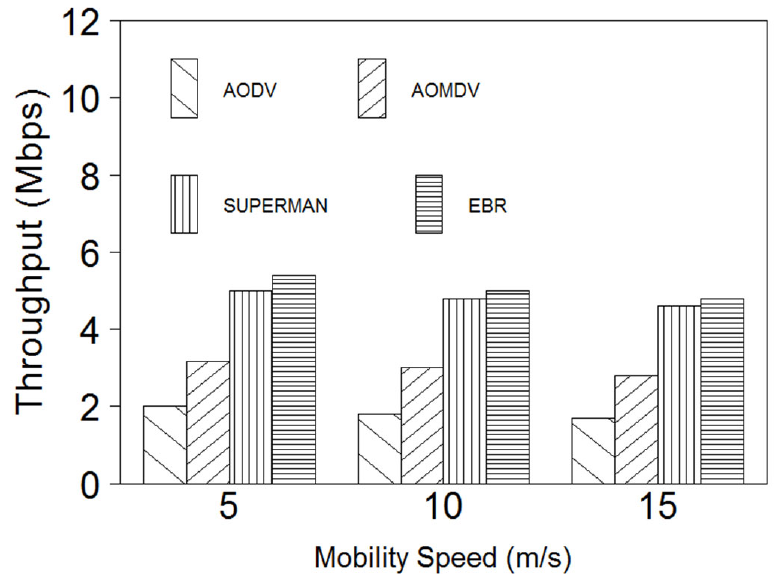
Figure 14. Throughput vs. mobility speed (with attack).